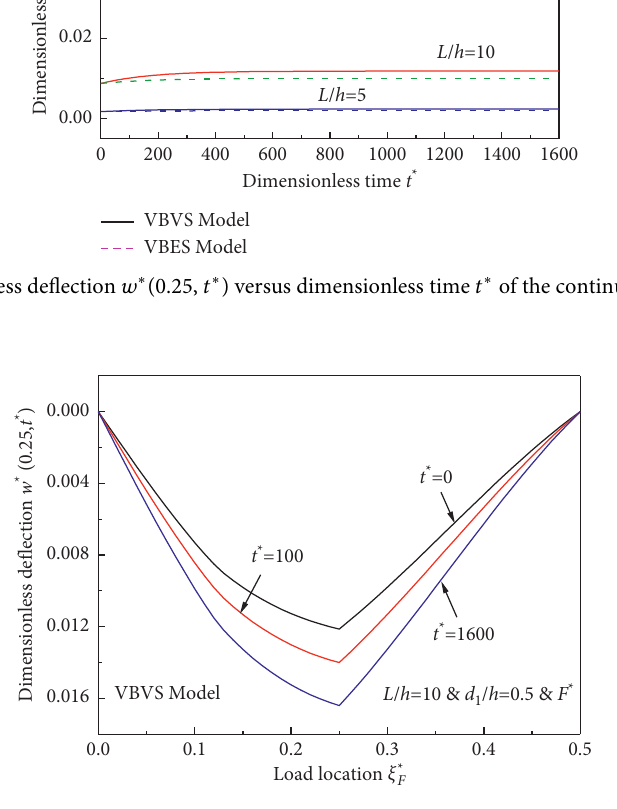
F of the continuous cracked